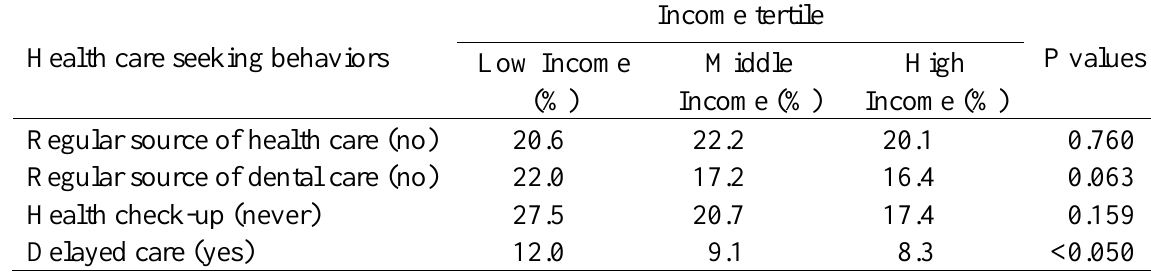
Table 2. Association between health care seeking behaviors, lifestyle, and income by age-adjusted % (N =